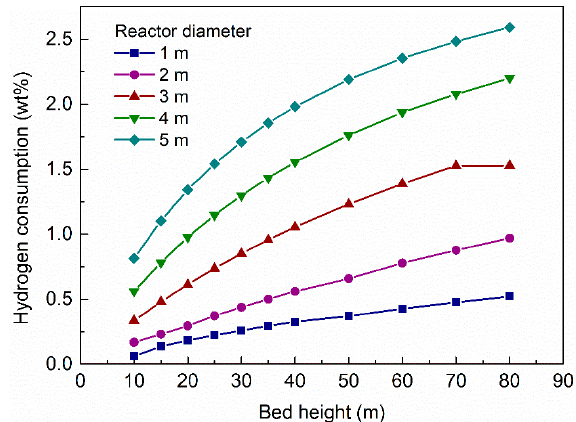
Figure 6. Impacts of bed height and reactor diameter on hydrogen consumption.